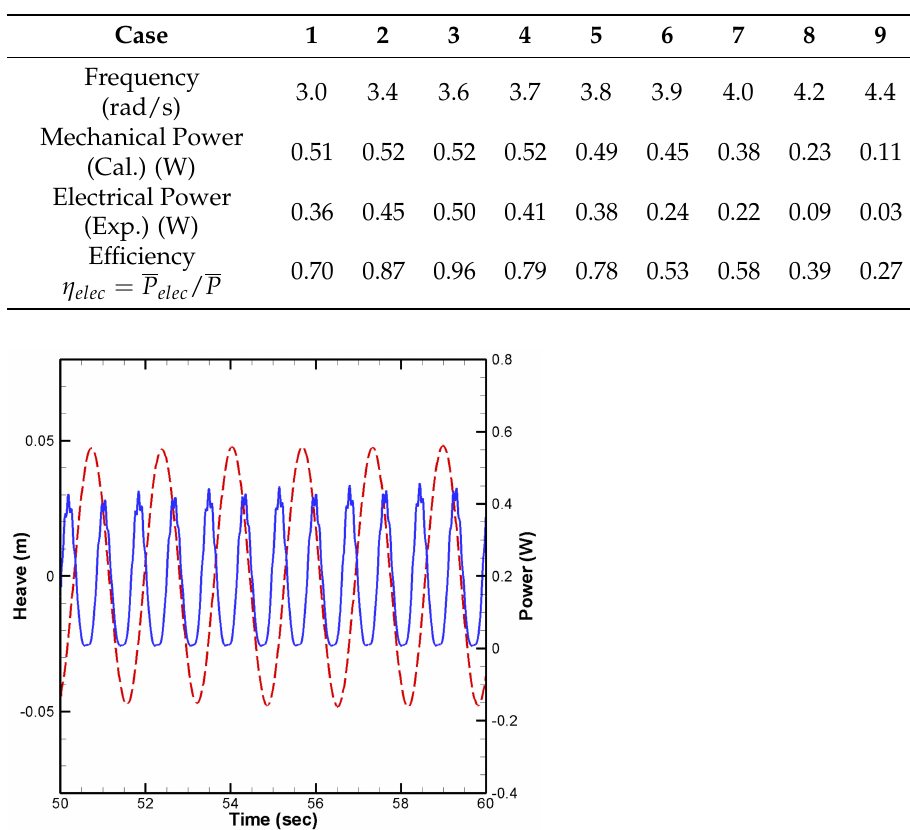
Table 7. Comparison of the time-mean extracted power between the analytical solutions and experi- mental results.